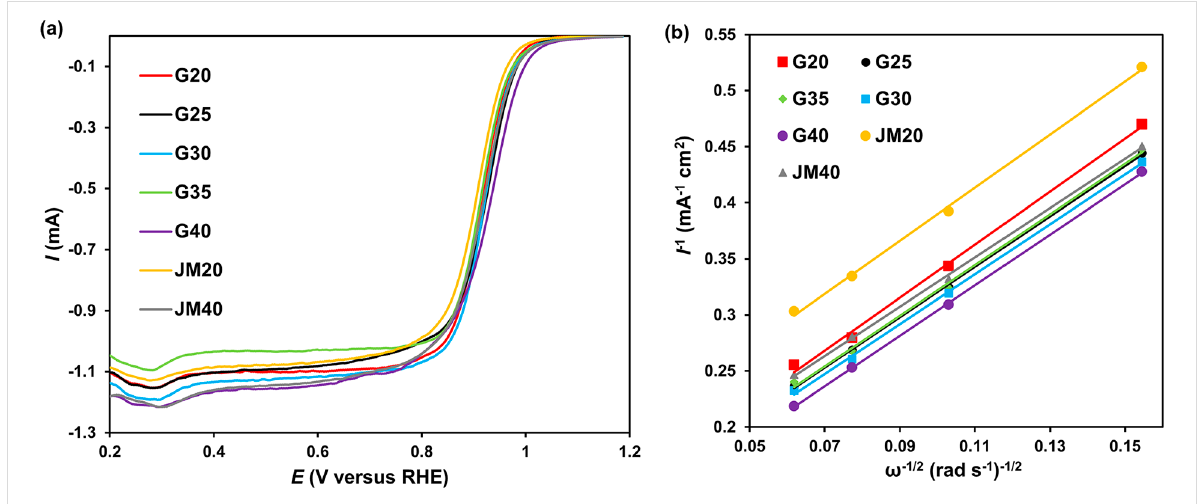
Figure 5: (a) Linear voltammograms of the ORR. The rotation speed of the disk is 1600 rpm − 1 , (b) j − 1 - ω − 0.5 dependence at a potential of 0.90 V. The rate of the potential sweep is 20 mV·s − 1 . Electrolyte used: 0.1 M HClO 4 solution saturated with O 2 at atmospheric pressure.